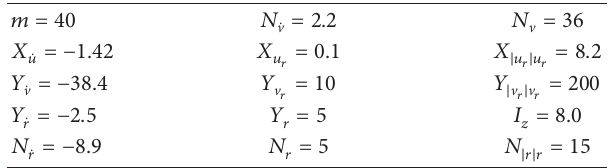
Table 1: UUV relevant